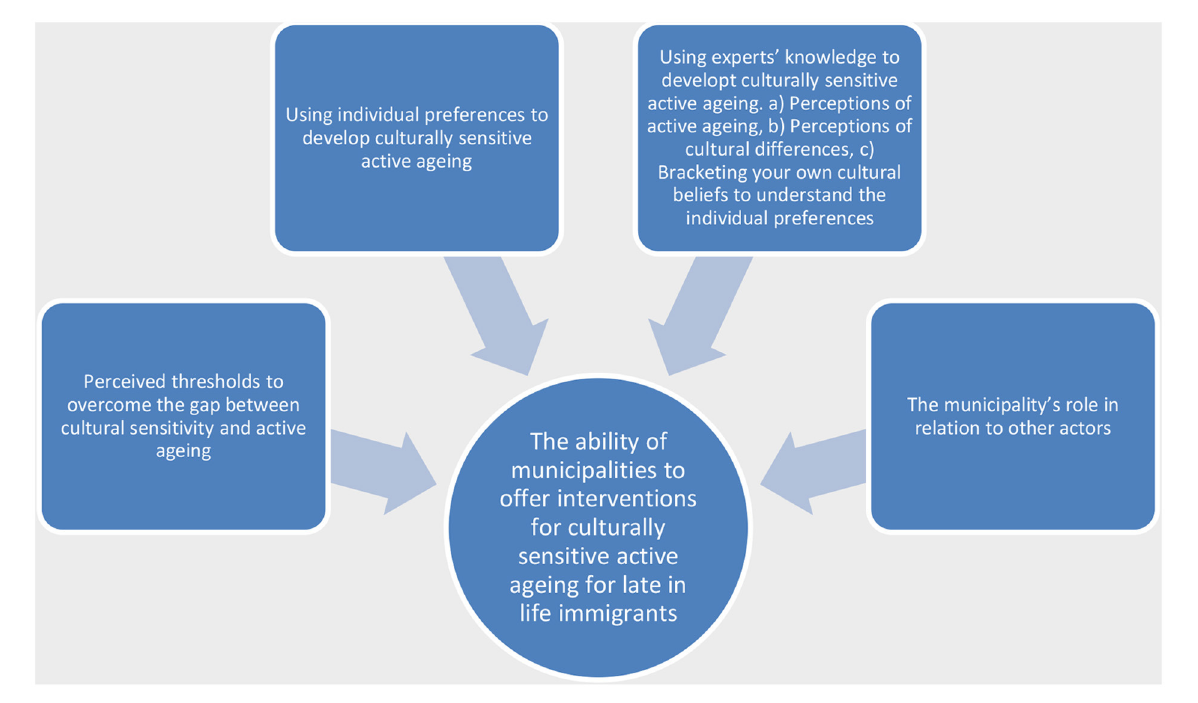
FIGURE1 The ability of municipalities to offer interventions for culturally sensitive active aging for late in life